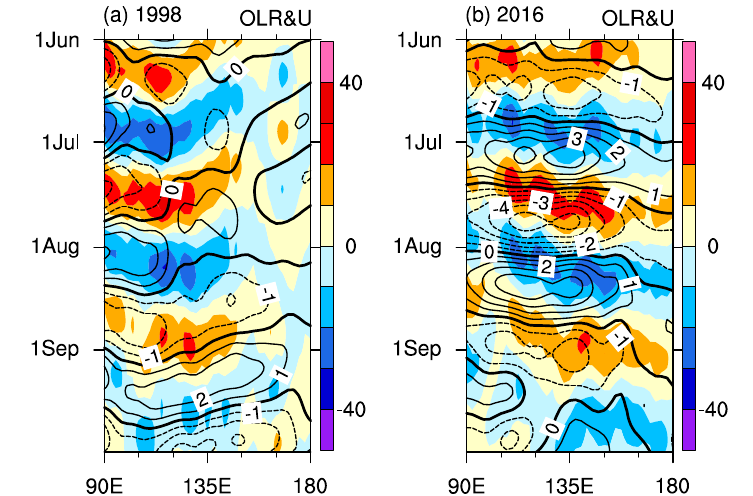
Figure 9. Same as in Figure 7 but for the results in July.